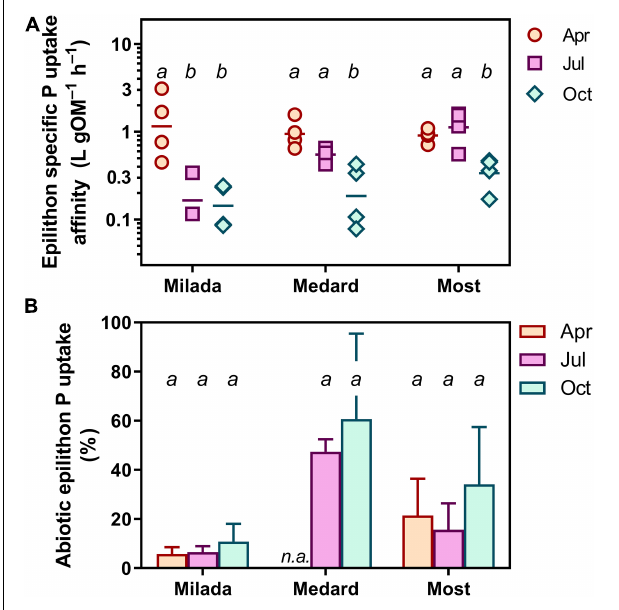
FIGURE 4 | P uptake parameters of epilithon in three post-mining lakes sampled in the Czech Republic in 2019. Symbols show individual values; different lowercase letters indicate significant seasonal differences within lakes ( p < 0.05; two-way ANOVA and Tukey’s multiple comparisons post-test). (A) Epilithon specific phosphorus uptake affinity ( SPUA E ). (B) Abiotic P uptake (adsorption). Columns show averages of four values from two sampling sites and two depths ± SD.